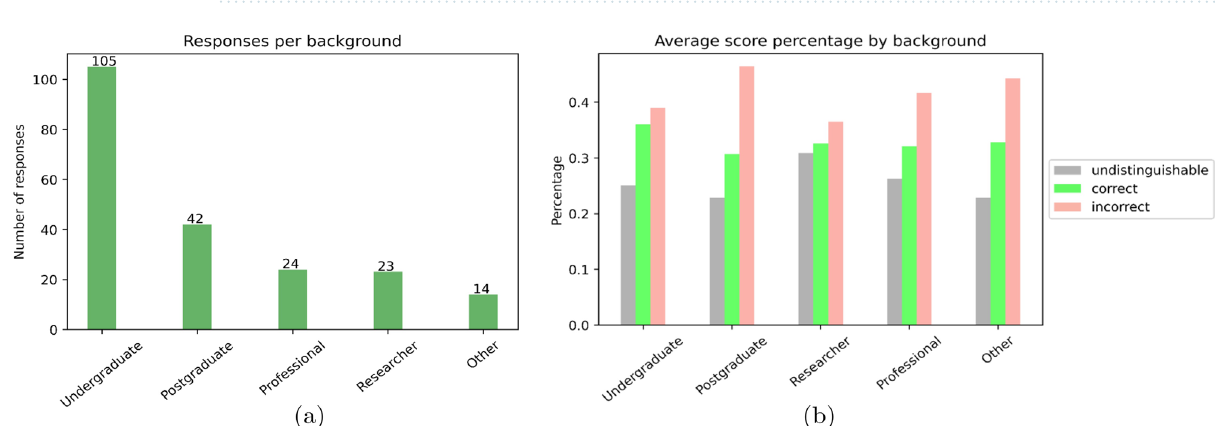
Figure 6. Comparison of different stages of training for selected images that generated ( a ) 74.59, ( b ) 32.84, and ( c ) 12.49.